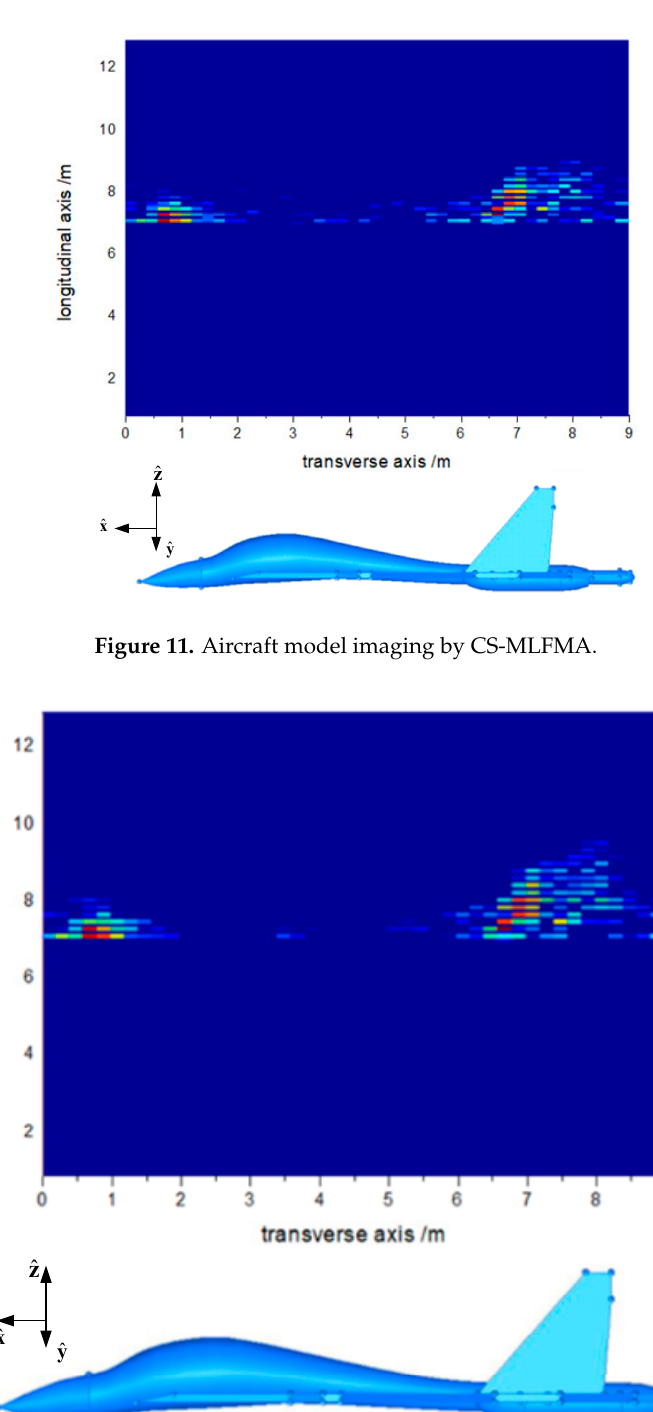
Figure 12. Aircraft model imaging by MLFMA.